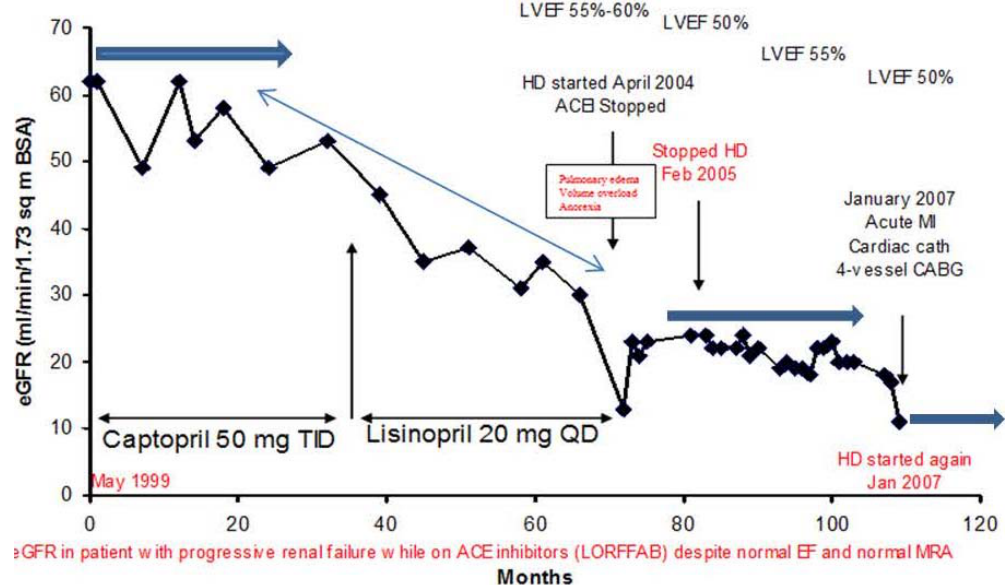
Figure 8. eGFR trajectory in the diabetic, hypertensive Caucasian male patient with features of LORFFAB.